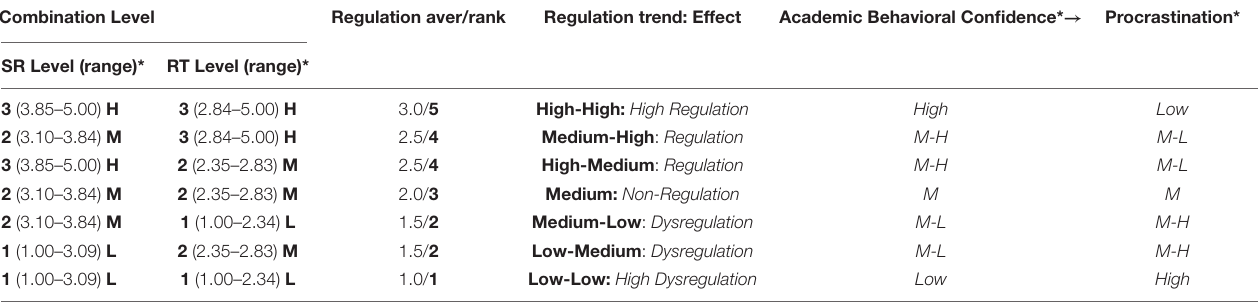
TABLE 1 | Combinations between model parameters hypothesized by SRL vs. ERL Theory (de la Fuente et al., 2017, 2019). Combination